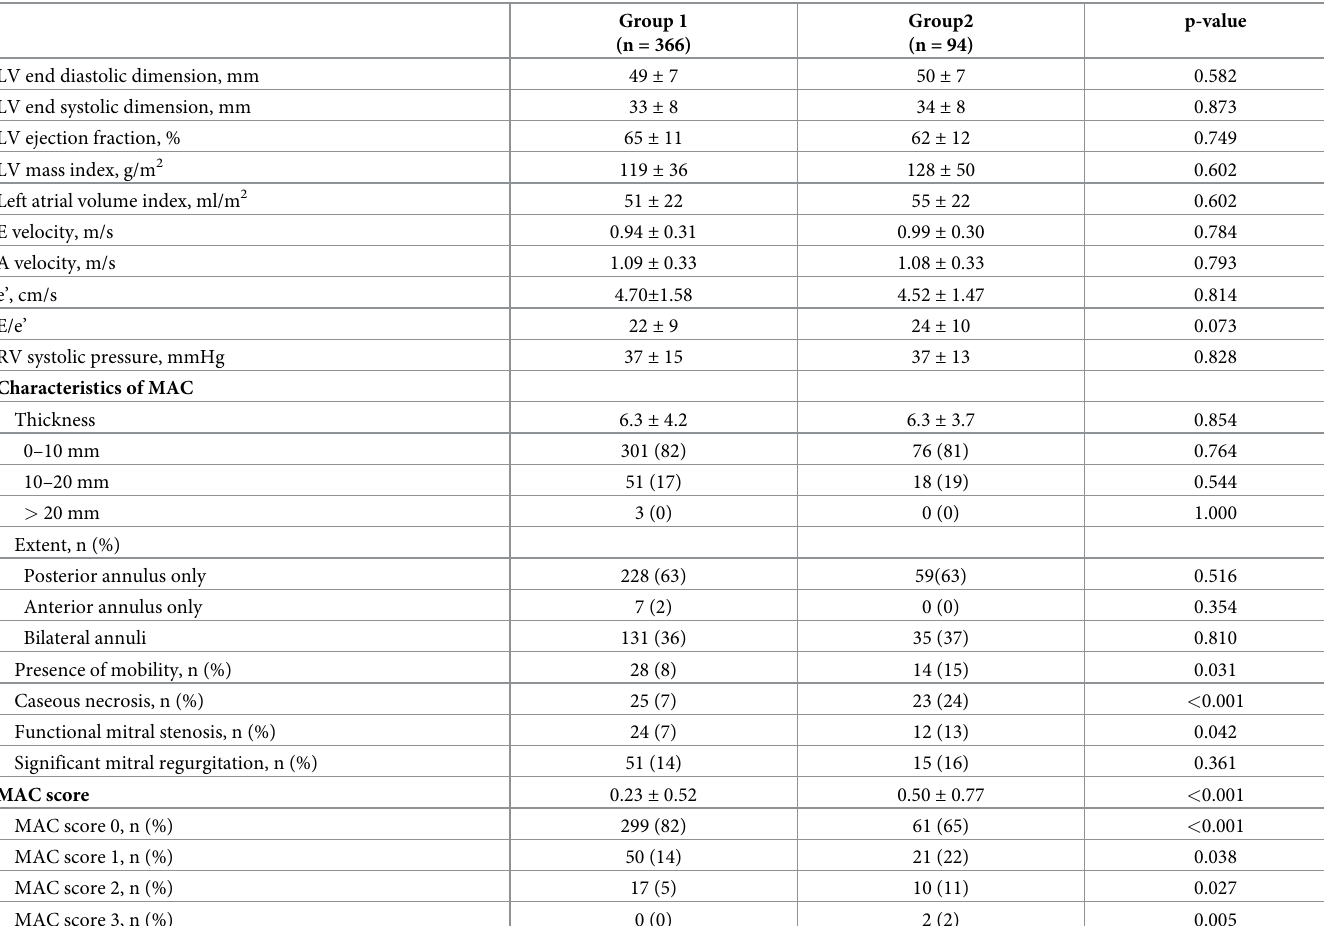
Table 2. Echocardiographic